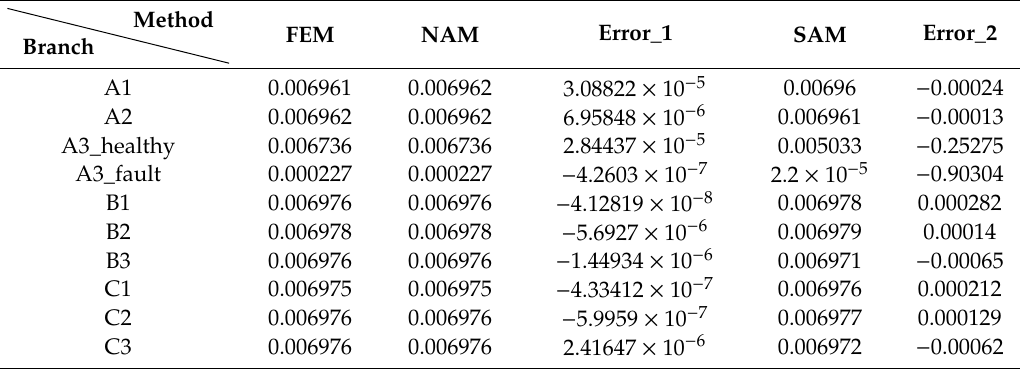
Figure 16. The inductances of the faulty coil when there are 18 turns shorted in different layers: ( a ) self-inductance in faulty part; ( b ) self-inductance in healthy part; ( c ) mutual